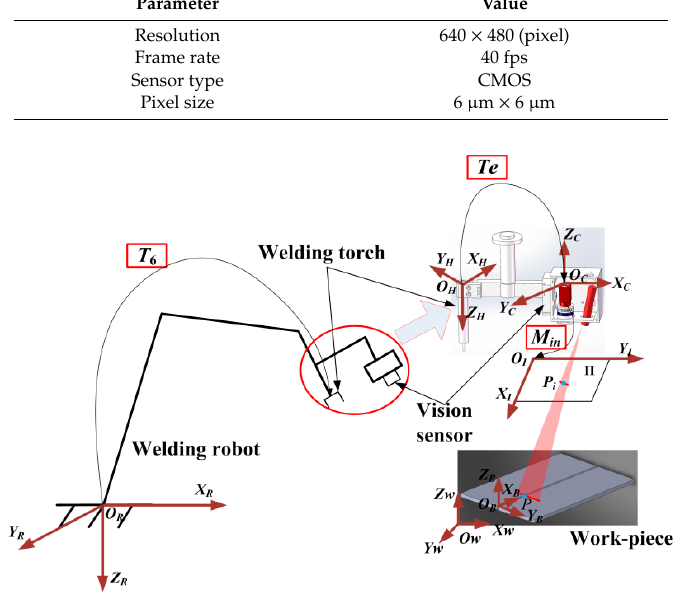
Figure 2. Coordinate transformation model.